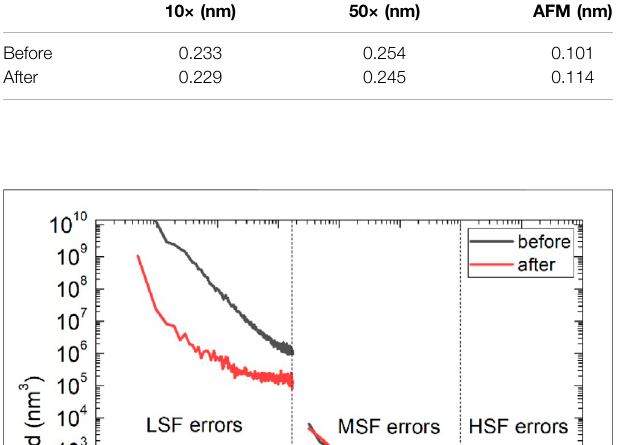
TABLE 1 | Surface roughness measured by using an optical pro fi ler and AFM before and after IBF. 10× (nm) 50× (nm)